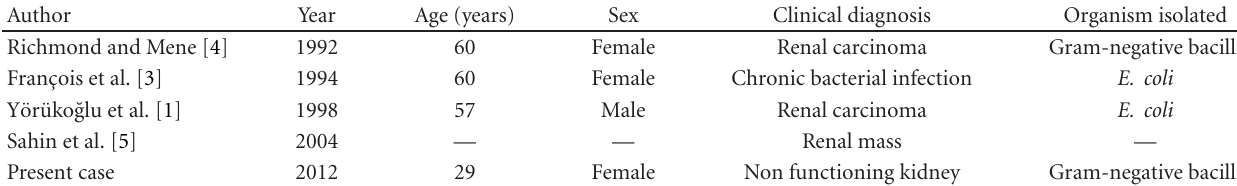
Table 1: Previous reported cases of renal